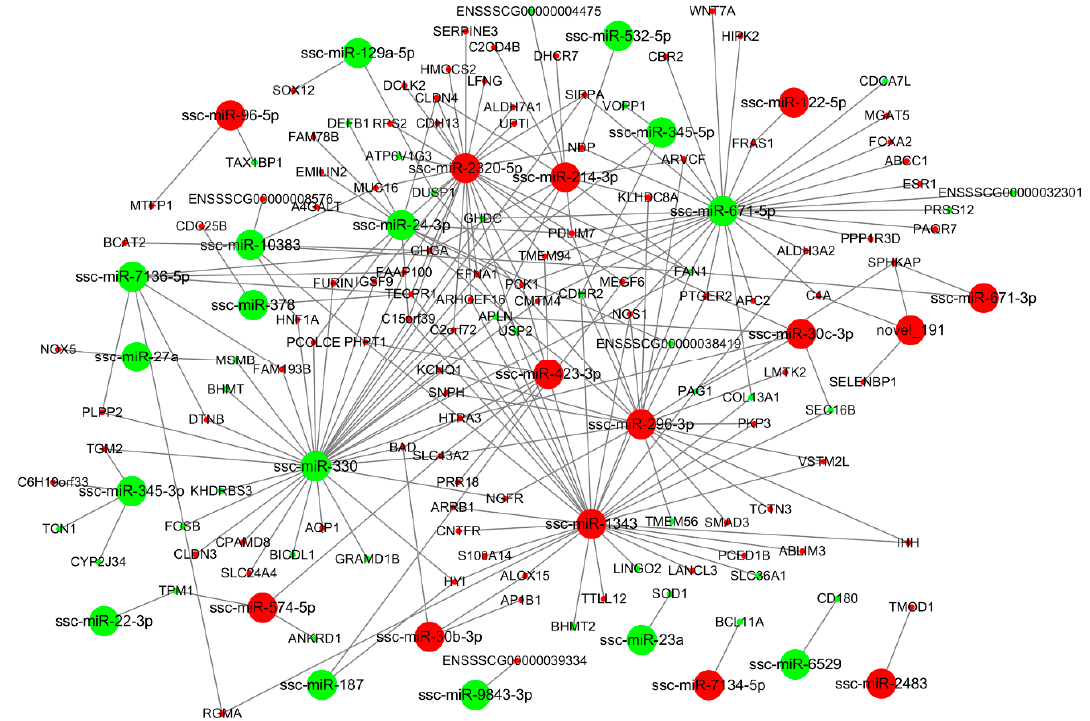
Figure 7. miRNA-gene interaction network (MS49 vs. MS72). Large and small circles represent miRNAs and genes, respectively. Red indicates that the RNA is relatively more abundant, and green indicates that the RNA is relatively less abundant in MS49 than in MS72.